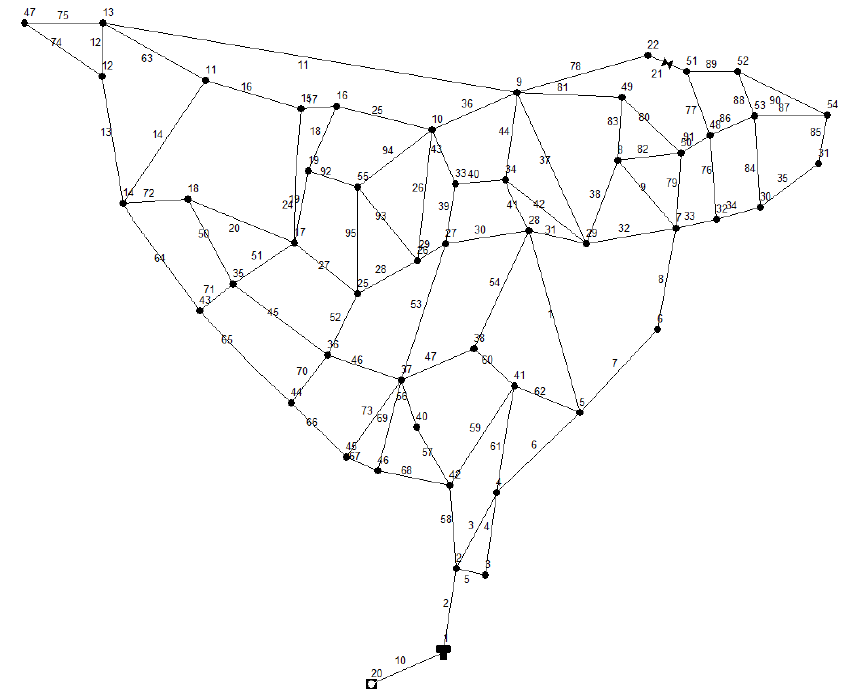
Figure 3. The water network of Spezzano Albanese (CS, Italy).